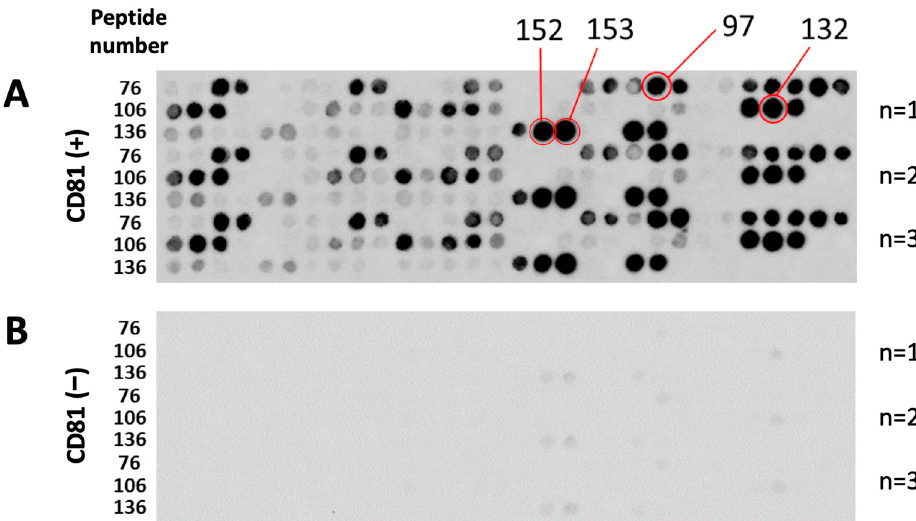
Figure 1. Fluorescent images of EWI-2 peptide array after binding assay with Alexa Fluor ® 488 − labeled CD81 protein. ( A ) EWI-2 peptide array bound to Alexa Fluor ® 488 − labeled CD81 protein (CD81 (+)). ( B ) EWI-2 peptide array bound to Alexa Fluor ® 488 dye (CD81 ( − ), blank). The red circles indicate CD81 − BP candidate spots.